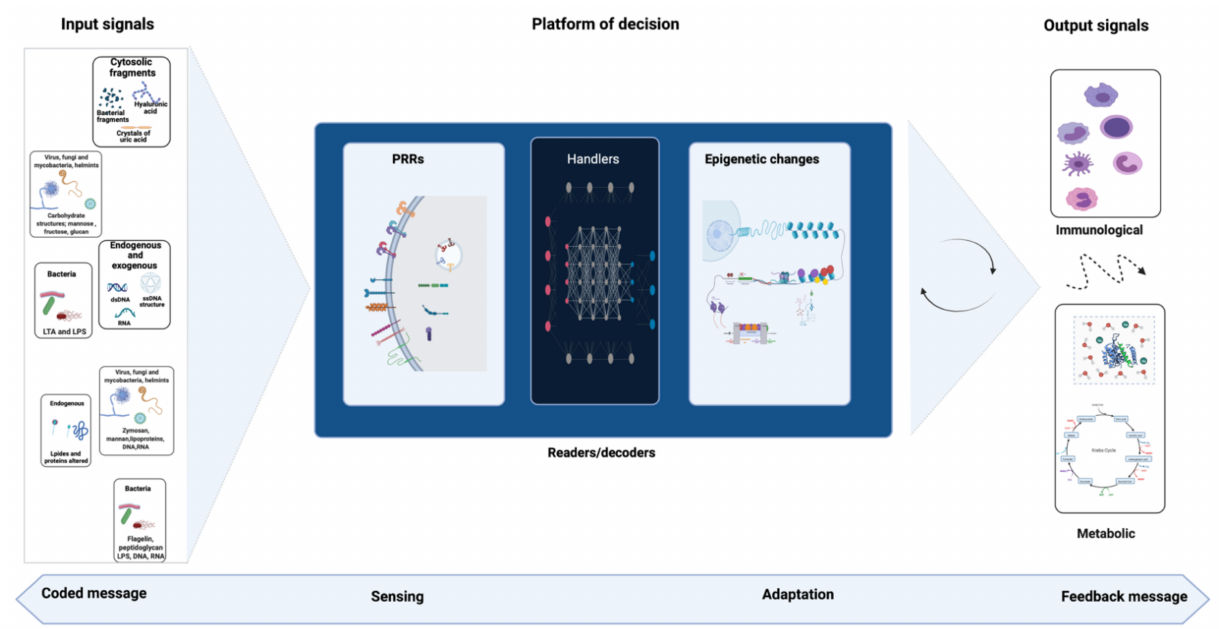
Figure 3. Handler elements connecting sensing and response (this figure was created with Biorender.com, accessed on 2 September